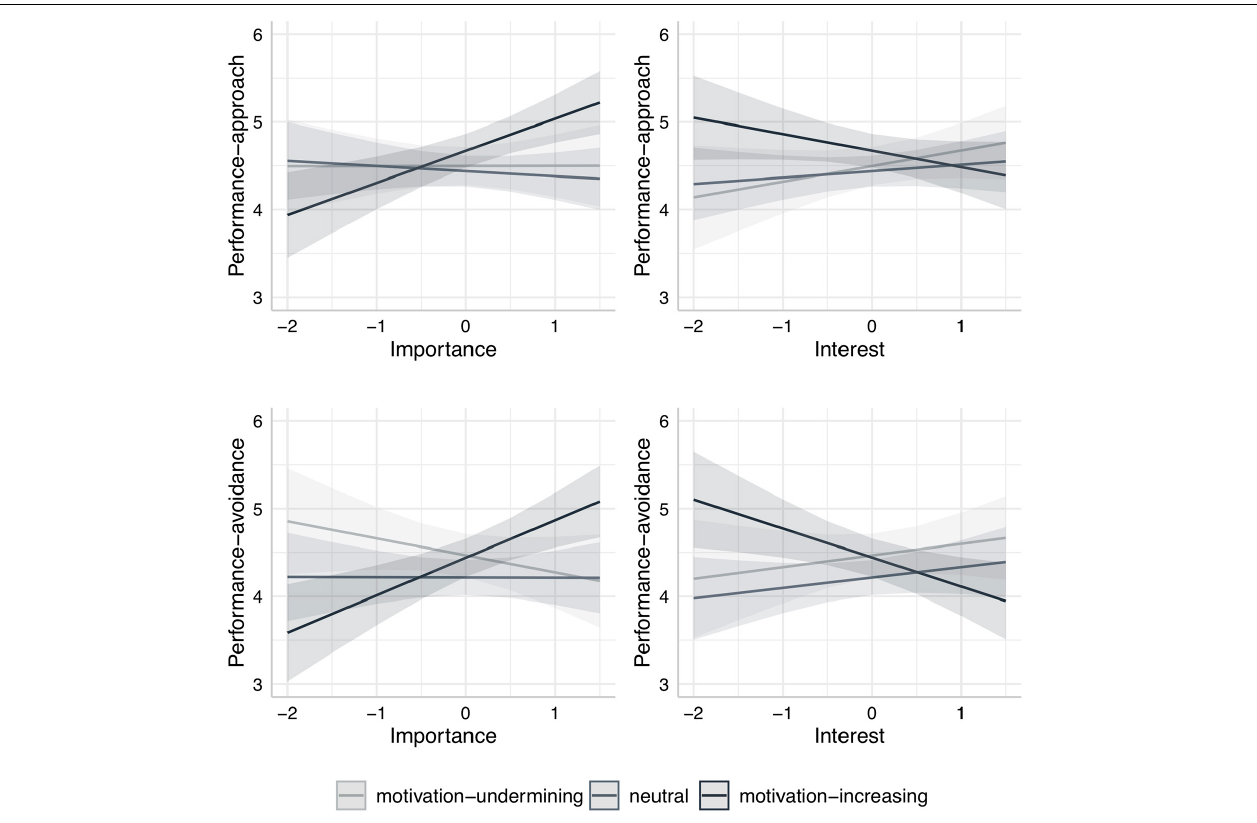
FIGURE 3 | Implicit belief profiles interact with importance and interest to predict performance-approach and performance-avoidance goals. Importance and interest values are standardized; performance-approach and performance-avoidance values have been left in their original units.